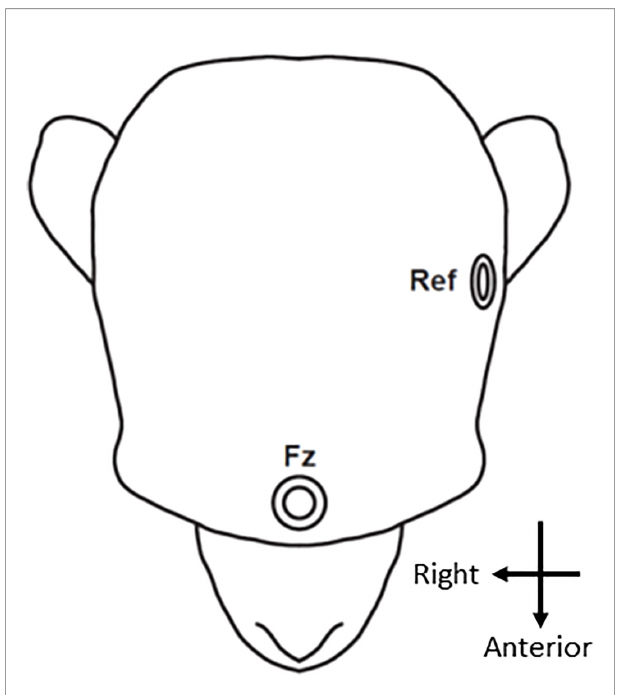
FIGURE 1 | Electrode location. The EEG signal was recorded from an electrode positioned in the frontal area (Fz). The reference electrode (Ref) was placed in front of the